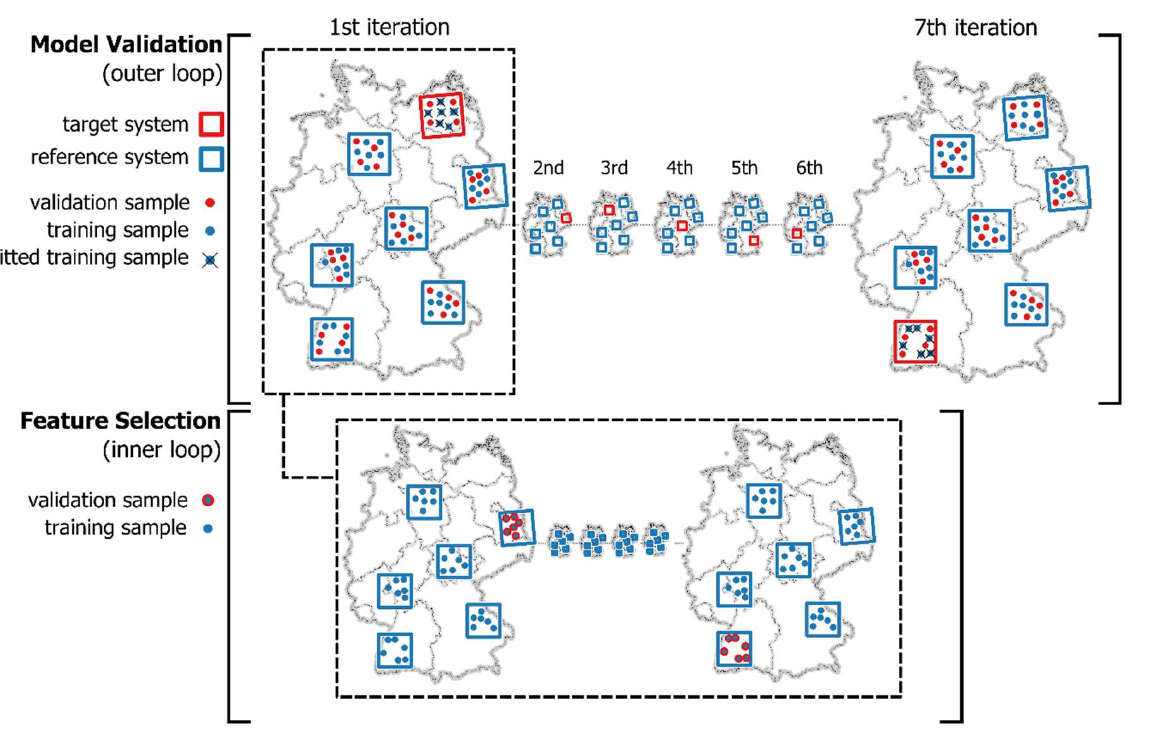
Figure 4. Graphical illustration of model validation and feature selection procedures. The pseudo- code of this workflow is provided in Supplementary Material A.